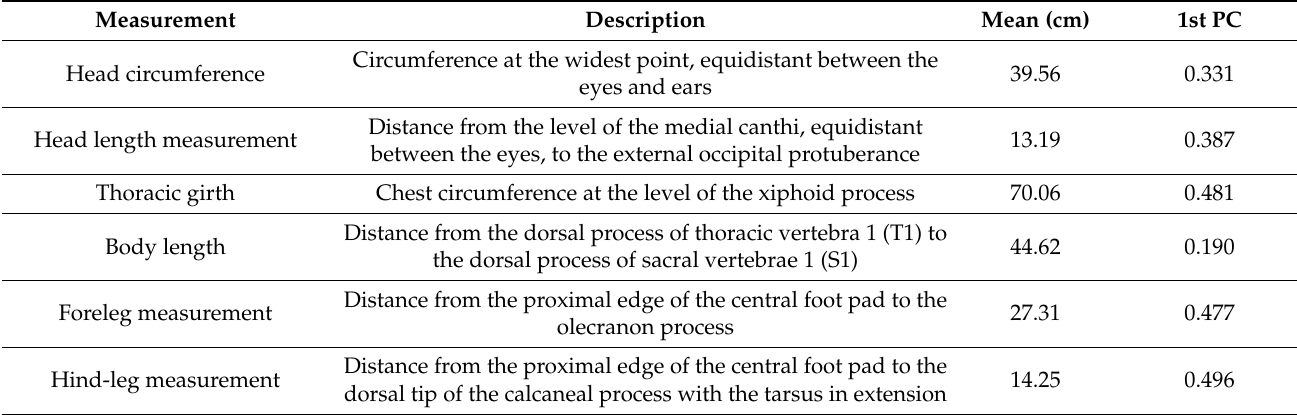
Table 1. Description of the six morphometric measurements (table is taken from Leung et al. [11]), in addition to the mean morphometric measurements and loadings for the first principal component from the eight Huntaway dogs enrolled in this